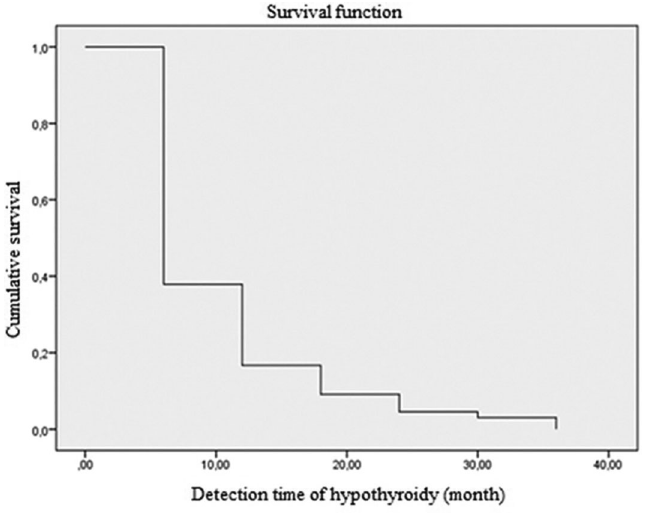
Figure 3. The risk of developing hypothyroidism according to time using the Kaplan-Maier